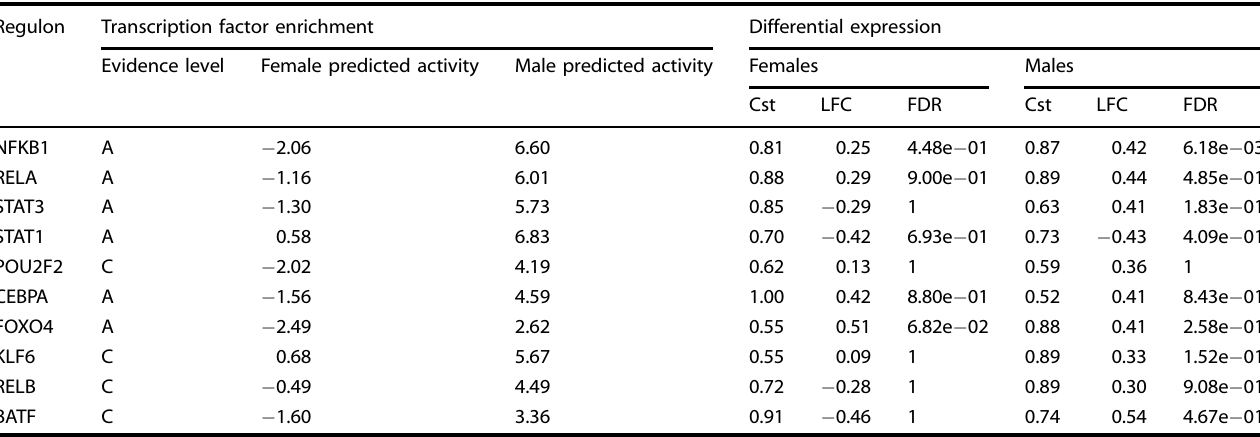
Table 3. Top ten transcription factors enriched in differentially expressed target genes.